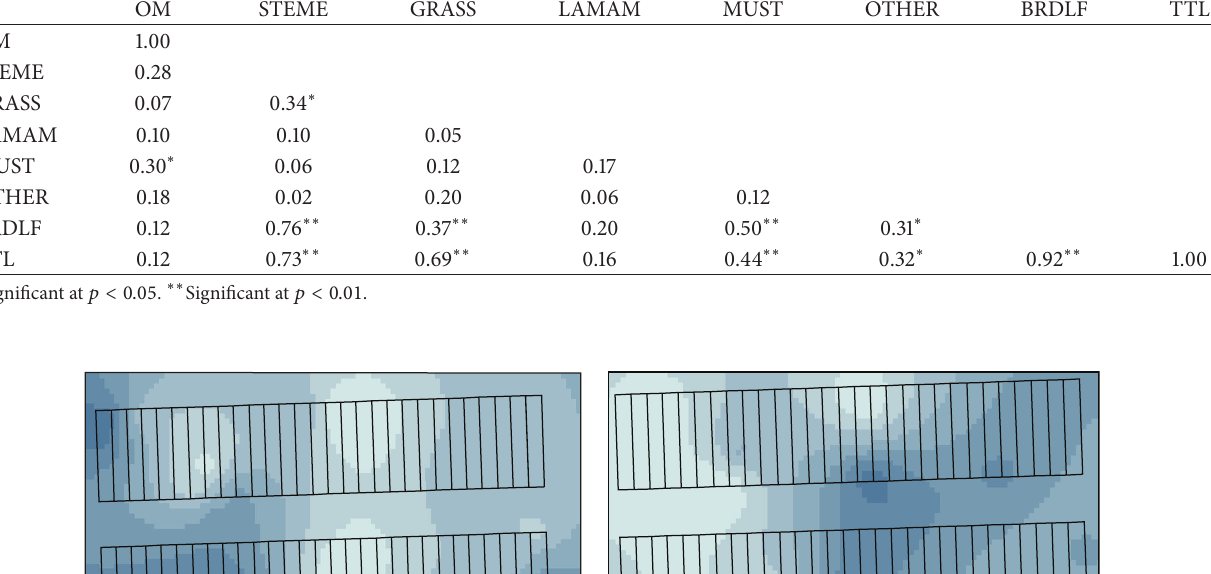
weeds was highly correlated with BRDLF ( 𝑟 = 0.92 ),